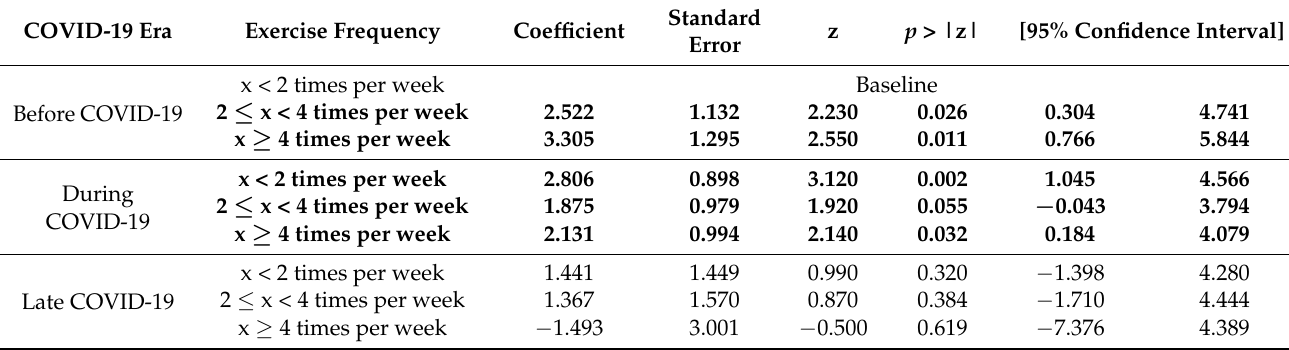
Table 9. The effect of the COVID-19 era and physical exercise frequency on mental distress in men during